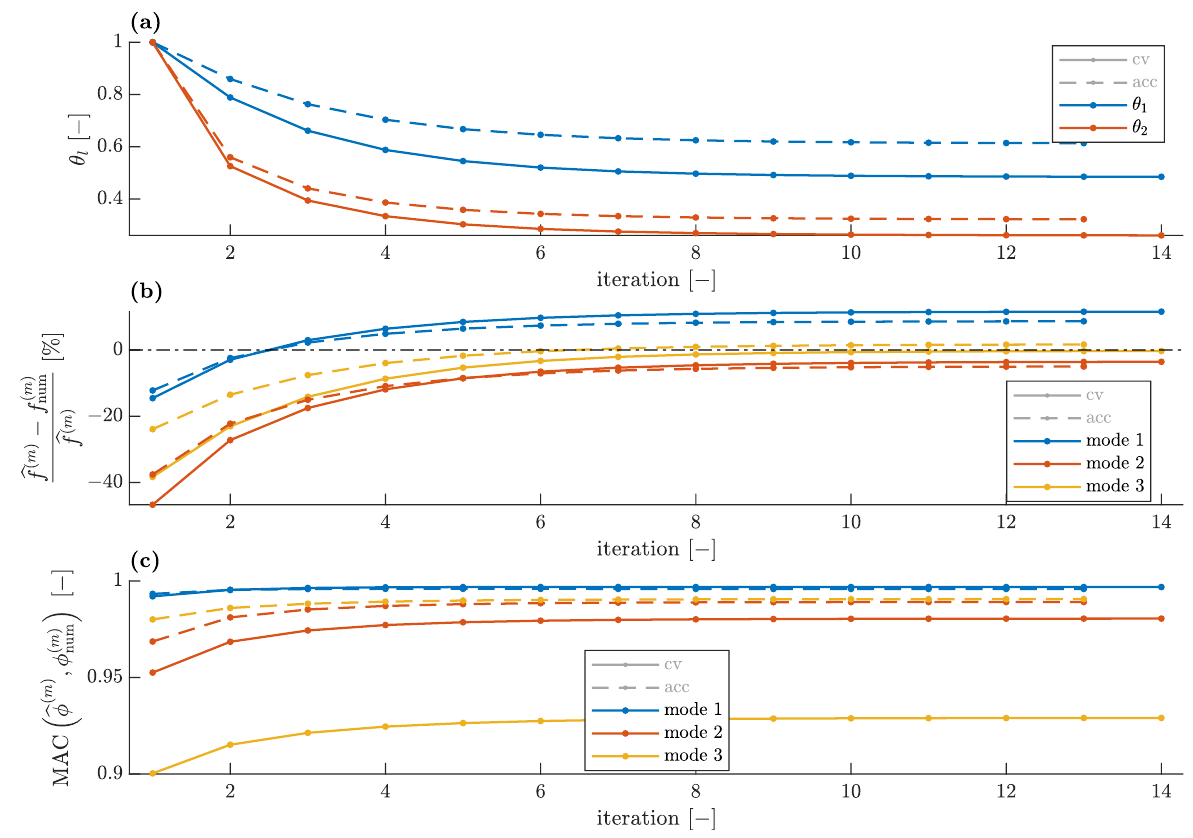
Figure 13. Comparison of convergences of model updating employing accelerometer and CV modal data for two unknown parameters: ( a ) unknown parameters, ( b ) relative natural frequency error and ( c ) modal assurance